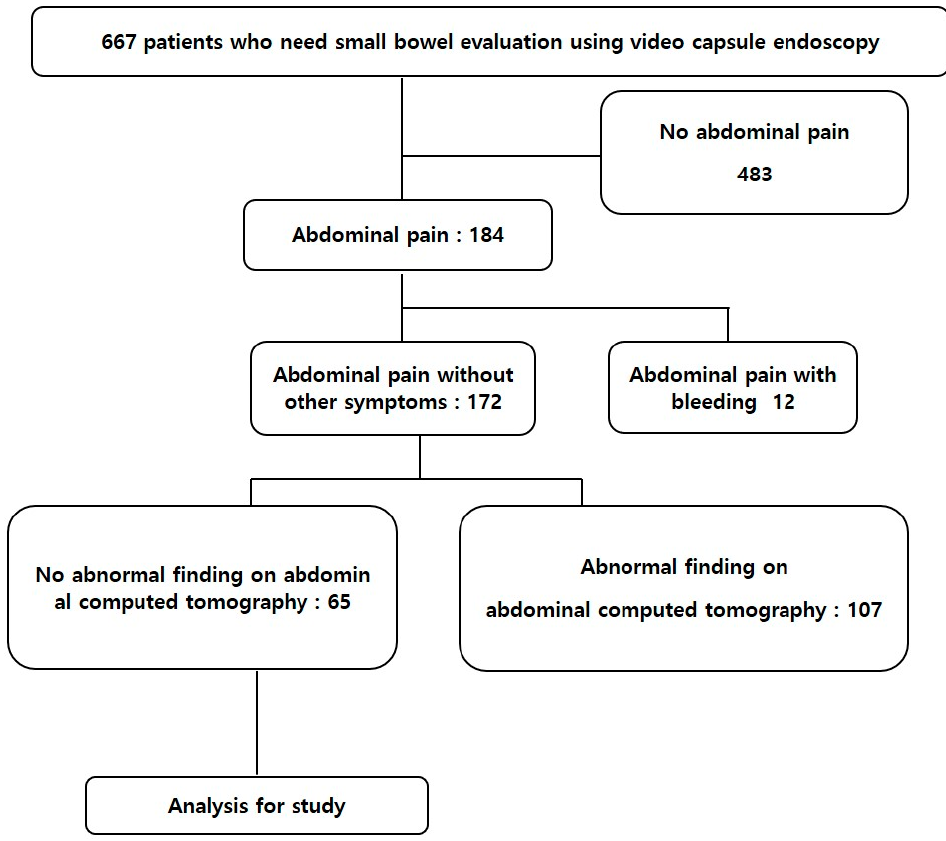
Figure 1. Flowchart showing patient inclusion.